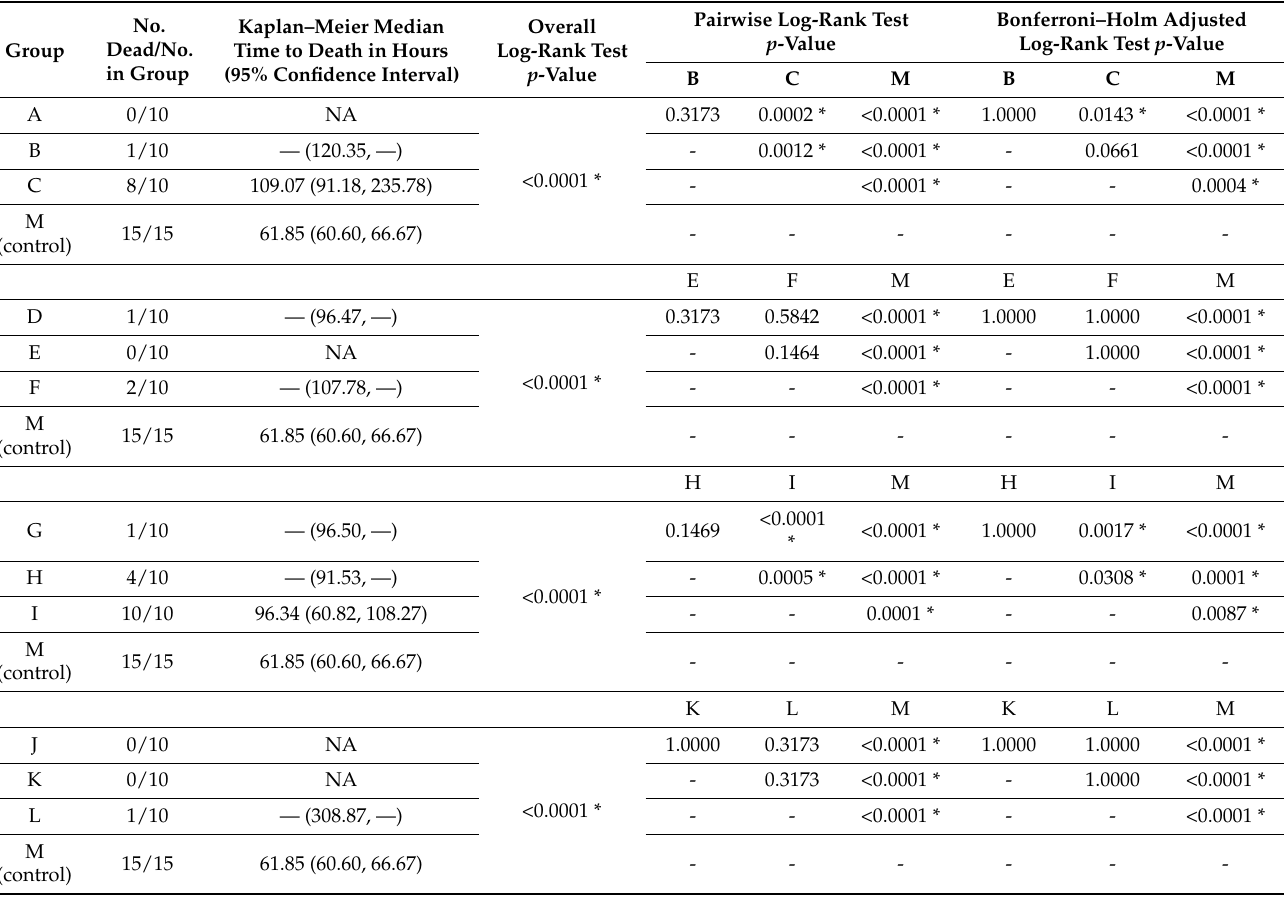
Table 2. Time-to-death data per treatment